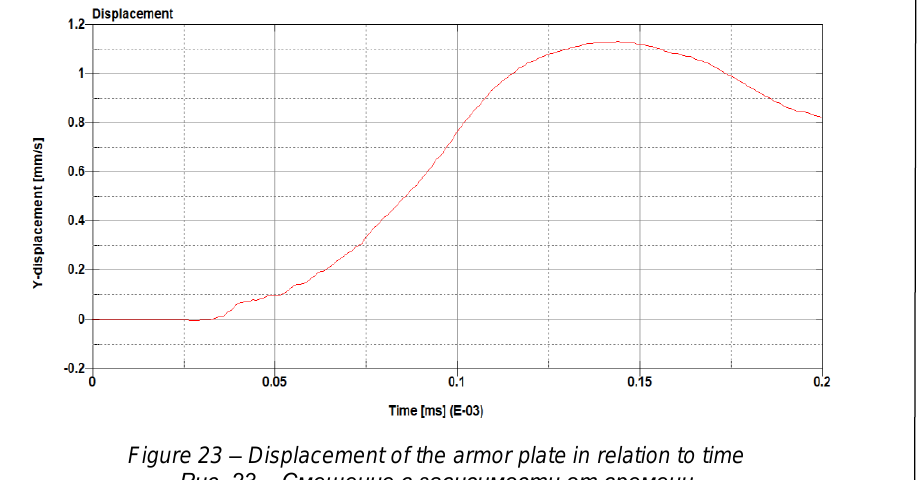
Figure 23 – Displacement of the armor plate in relation to time Рис. 23 – Смещение в зависимости от времени Слика 23 – Померање у зависности од